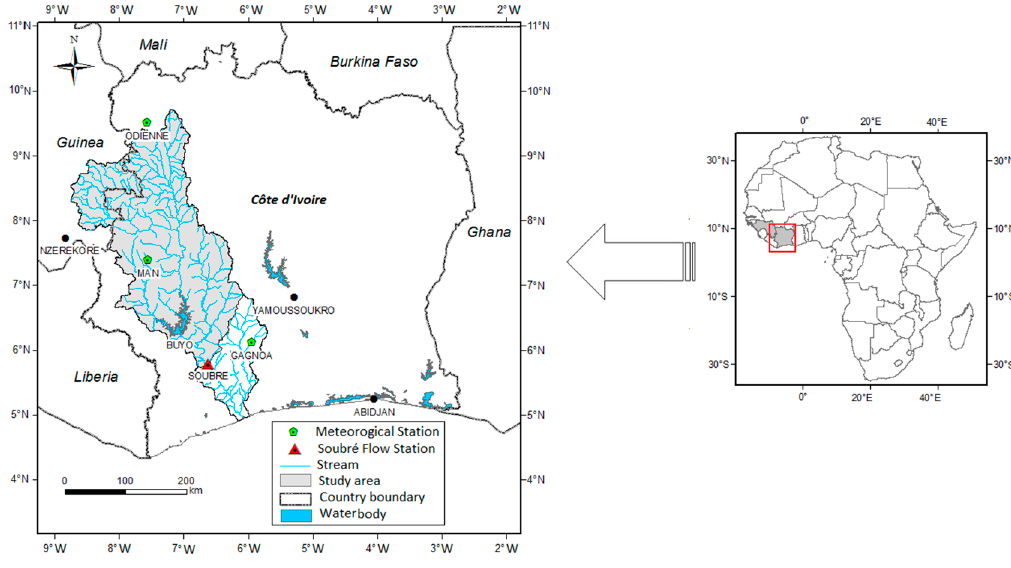
Figure 1. Sassandra River Basin at Soubré.